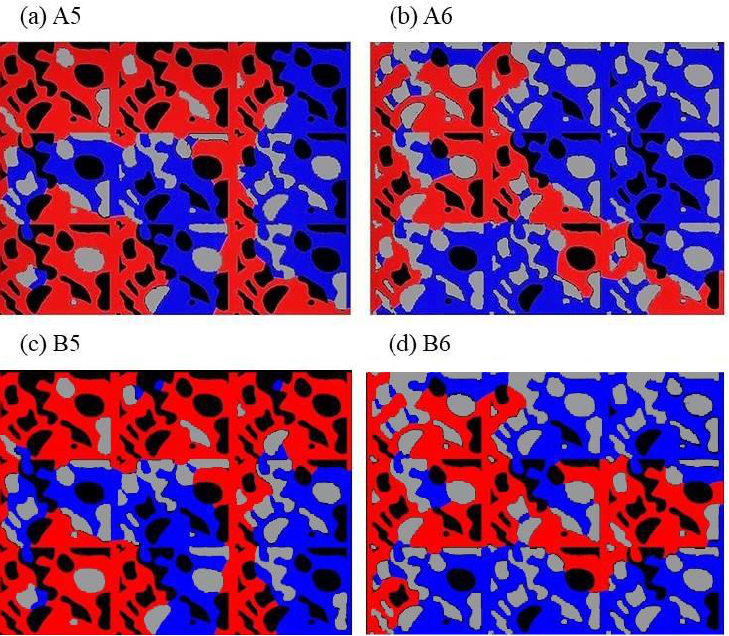
Figure 8. Gas and water distributions (gas-wet solid in gray, water-wet solid in black, and water in blue and gas in red) in porous structures with dalmatian wettability at the quasi-steady state: ( a ) A5—alternating gas-wet, r g − w = 1/3 and ( b ) A6—alternating gas-wet, r g − w = 2/3; ( c ) B5— alternating gas-wet, r g − w = 1/3; ( d ) B6—alternating gas-wet, r g − w = 2/3.